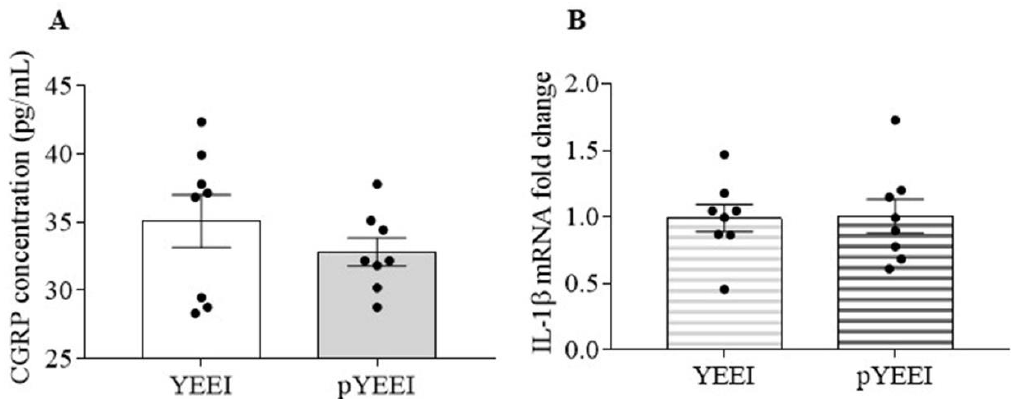
Figure 1. pYEEI alone did not alter CGRP release and IL-1 β gene expression in the mouse TG. ( A , B ) Effects of 1 mM pYEEI or 1 mM YEEI ( n = 8 per group) on CGRP release (pg/mL) and IL-1 β mRNA level at 20 min post treatment. IL-1 β mRNA level was present in the fold change relative to the geometric mean of β -actin and PPIA mRNA levels. Two-tailed unpaired t -test was used for the comparison in CGRP release and IL-1 β mRNA level between the YEEI group and the pYEEI group.